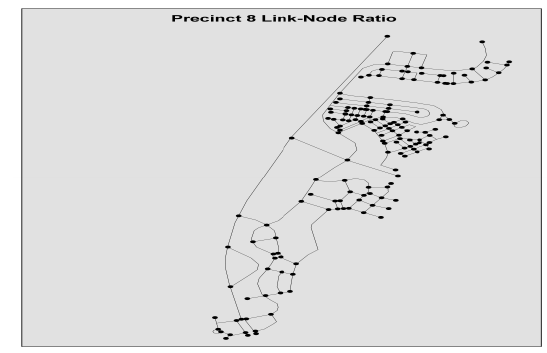
Fig.8: Lower Walkablity Precinct 8’s Link Node Ratio